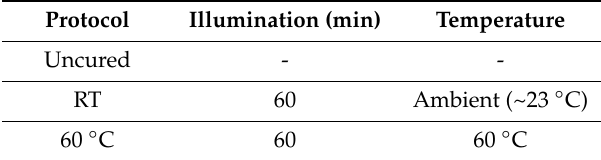
Table 2. Details of the three post curing protocols used for this work.